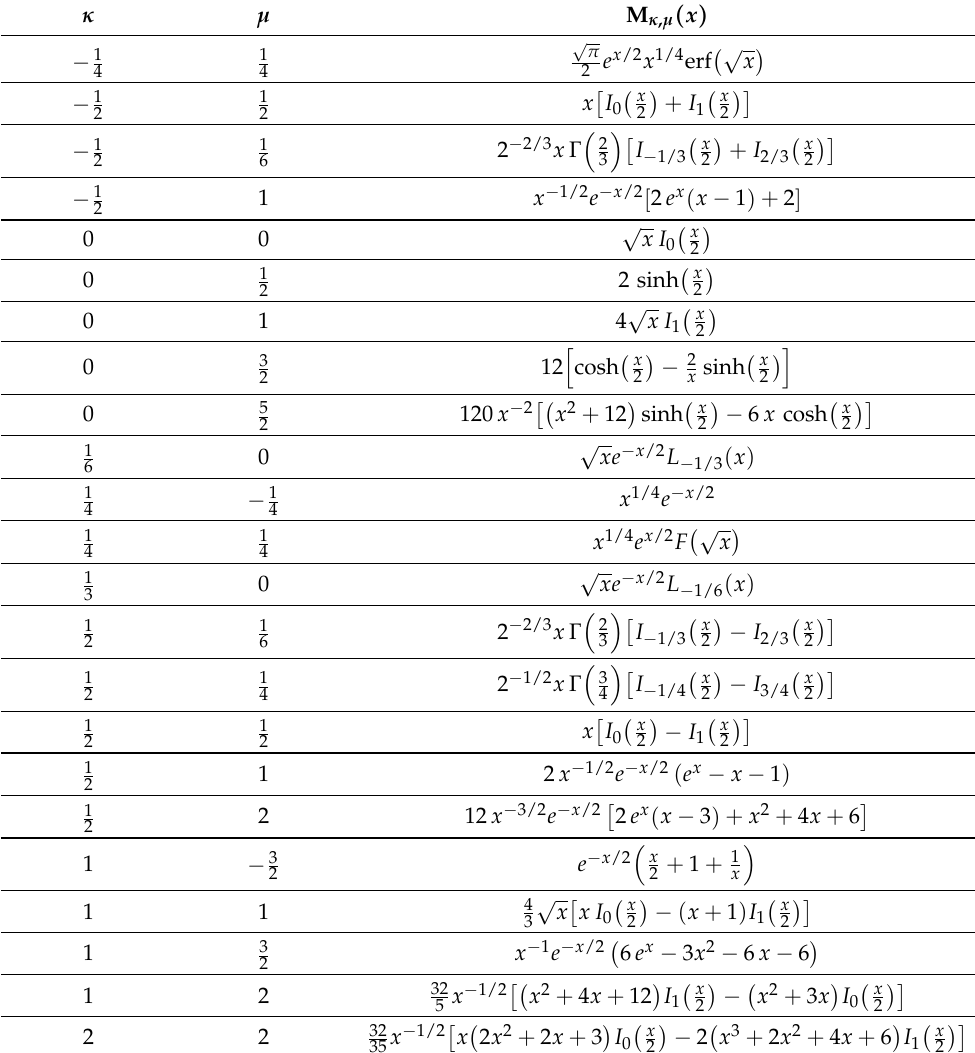
Table A1. Whittaker function M κ , µ ( x ) for particular values of κ and µ